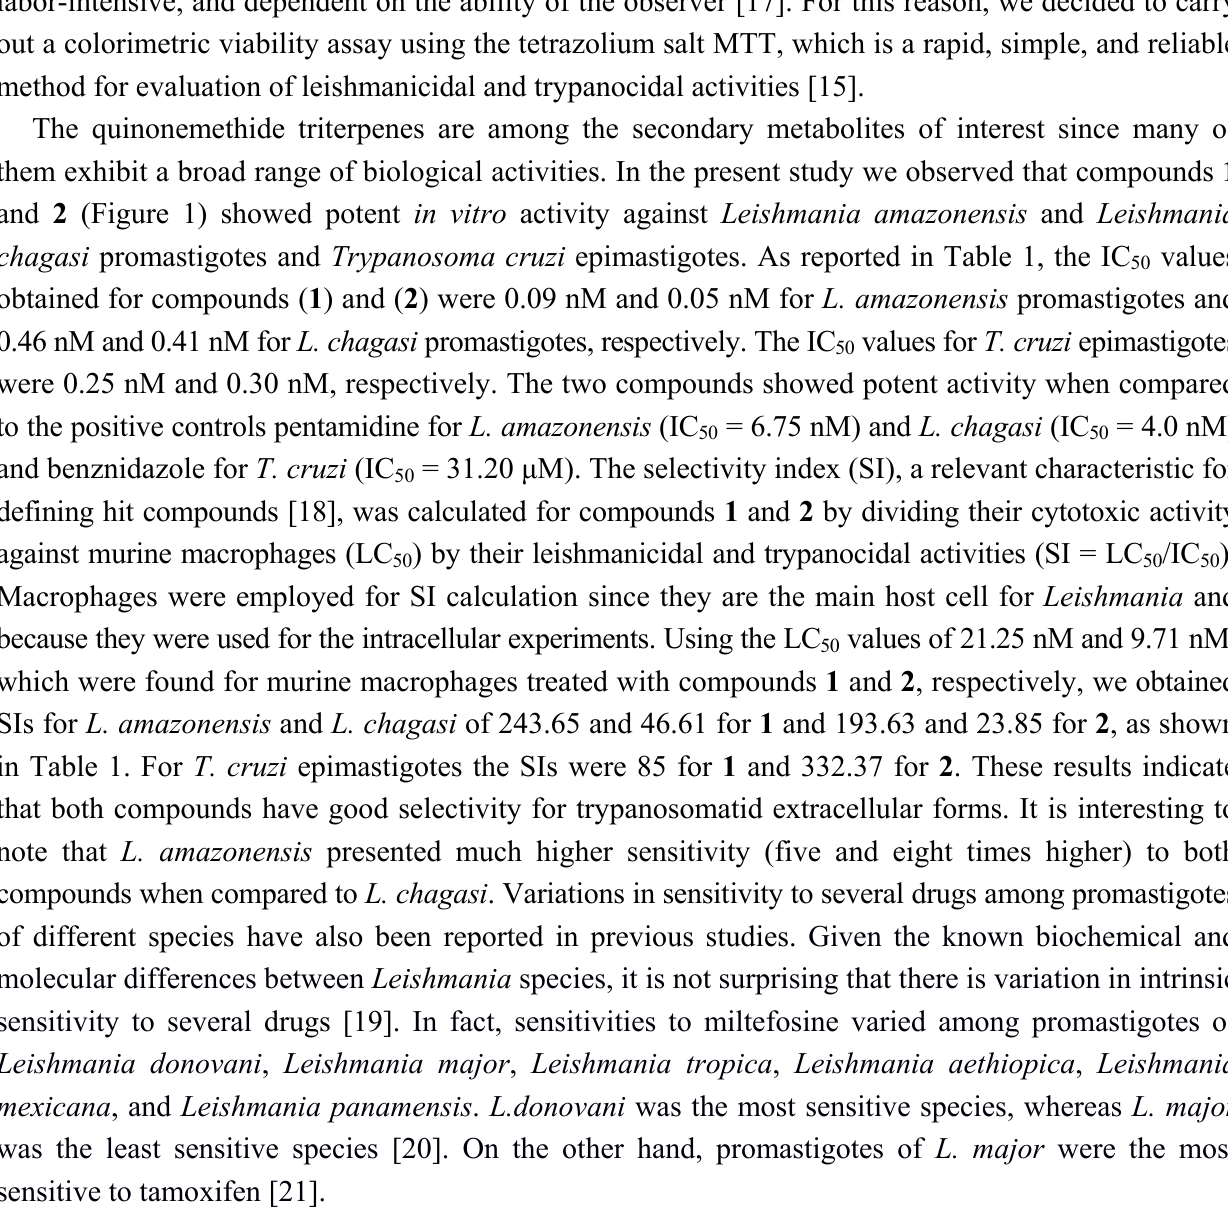
Figure 1. Chemical structures of compounds 1 and 2 from M. ilicifolia